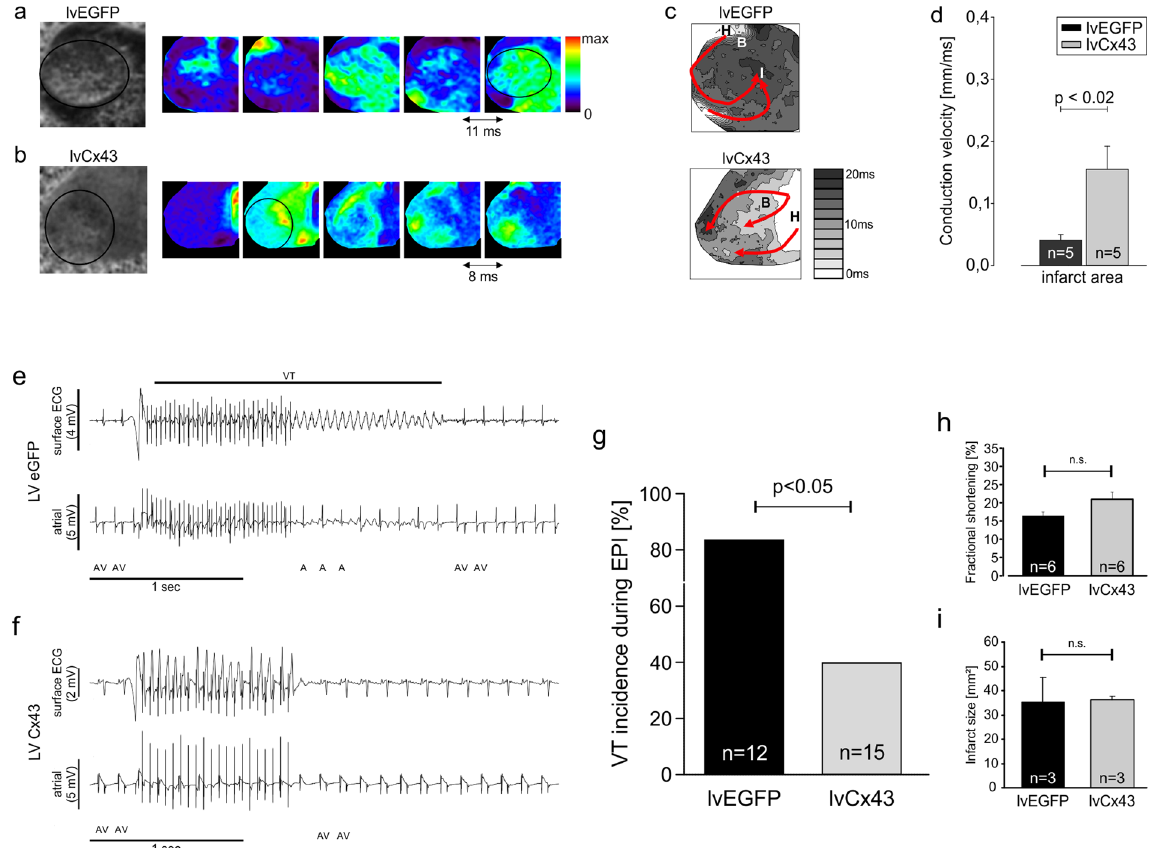
Figure 4. Injection of lvCx43 into the myocardial scar increases conduction in Langendorff-perfused hearts and provides long time protection against VT in vivo . ( a – d ) Optical mapping ( a ) Overview of a representative lvEGFP injected heart (leftmost panel, infarct region is encircled). Under sinus rhythm and unipolar pacing from the base of the heart, sequential di-4-ANNEPS fluorescence images display highly irregular and atypical conduction paths surrounding the lesioned area (images every 11 ms). ( b ) Also lvCx43 injected hearts revealed atypical propagation patterns, but some conduction through the scar area is visible (images every 8 ms). ( c ) Isochronal maps (same hearts as in a and b) depicting the activation wavefront and conduction delays near the infarct border zone. The activation bypasses the lvEGFP injected infarct (upper panel), but propagates through the lesioned area in the lvCx43 injected heart (lower panel); H, healthy; B, border zone; I, infarct. Scale bar indicates local activation times. ( d ) Local conduction velocities at 200 ms pacing. Note its significant increase in the infarct area (p = 0.0173) of lvCx43 injected hearts (n = 5) vs lvEGFP injected control hearts (n = 5). ( e , f ) Representative traces during in vivo burst stimulation 2 months after lentiviral gene transfer recorded from a lvEGFP ( e ) and a lvCx43 ( f ) injected heart. In the lvEGFP heart onset of VT shortly upon burst stimulation is observed (e), whereas no VT is induced in the lvCx43 heart (f); Top trace, surface ECG; bottom trace, atrial intracardiac lead; A, atrium; V, ventricle. ( g ) Statistical analysis of VT incidence shows a significantly (p < 0.05) lower incidence in the lvCx43 compared to lvEGFP control hearts. ( h , i ) There is no difference in left ventricular function (fractional shortening, h ) and infarct size ( i ) between lvEGFP and lvCx43 injected hearts 8 weeks after gene